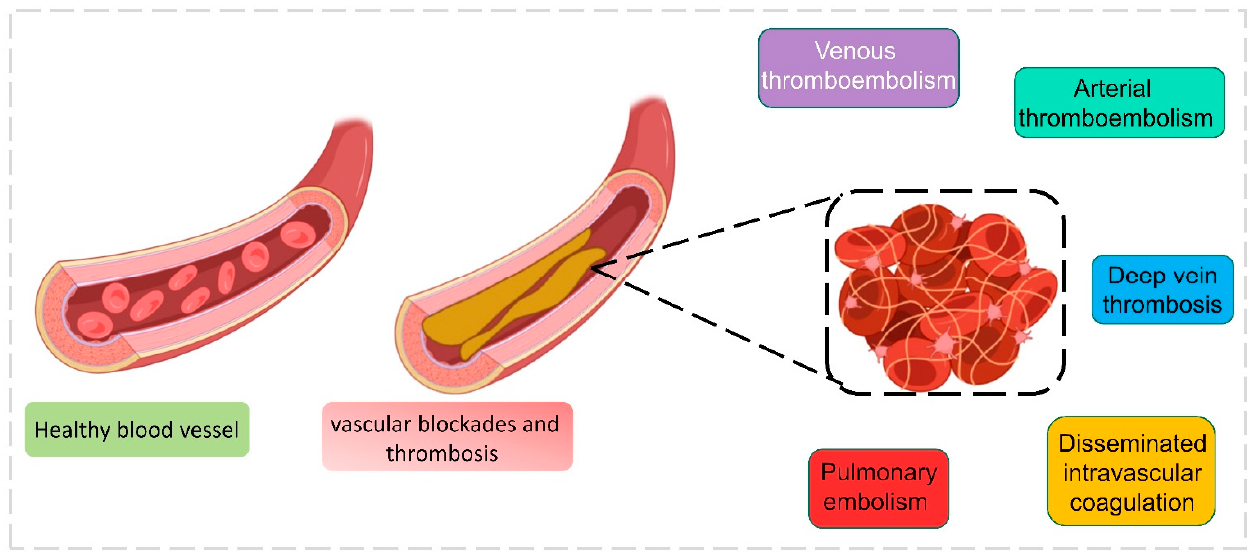
Figure 7. Different types of blood coagulation during the COVID-19 infection.